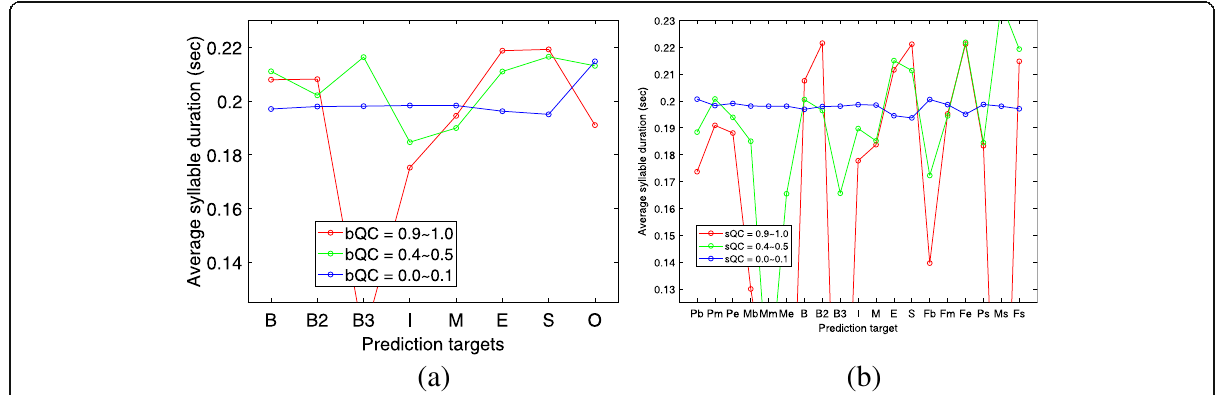
Fig. 10 Average syllable durations corresponding to the prediction targets for a bQC and b sQC in different levels of QC values